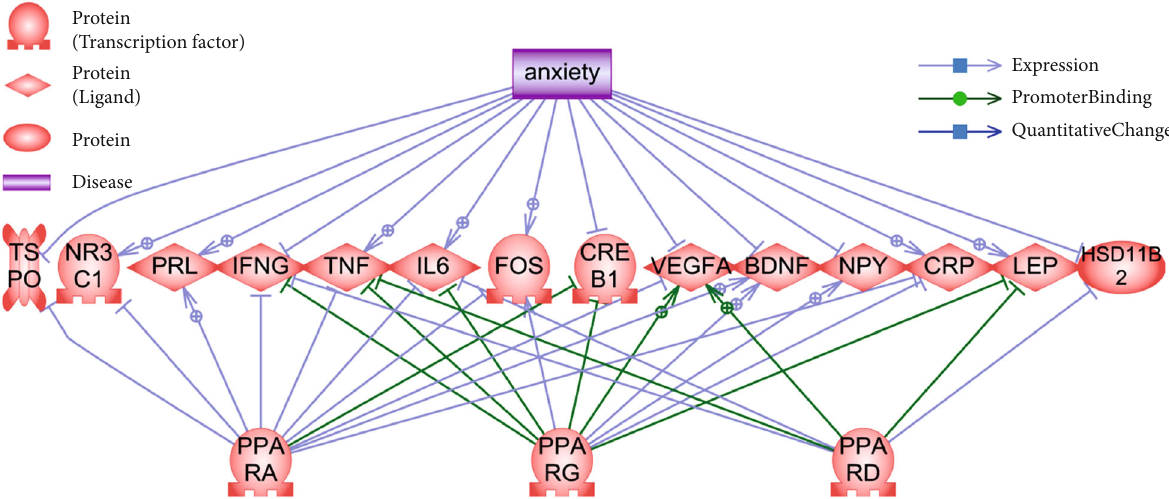
Figure 2: Common targets of anxiety and PPARs. Legend given on the The search algorithm for anxiety-protein-PPAR links